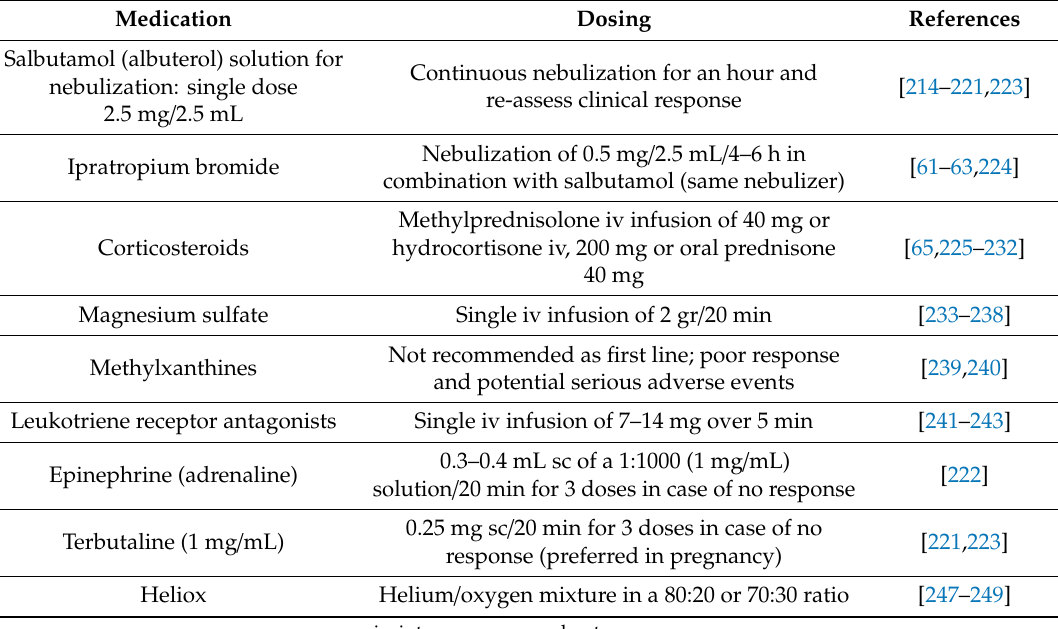
Table 2. Pharmacological management of patients with acute severe exacerbation in the emergency